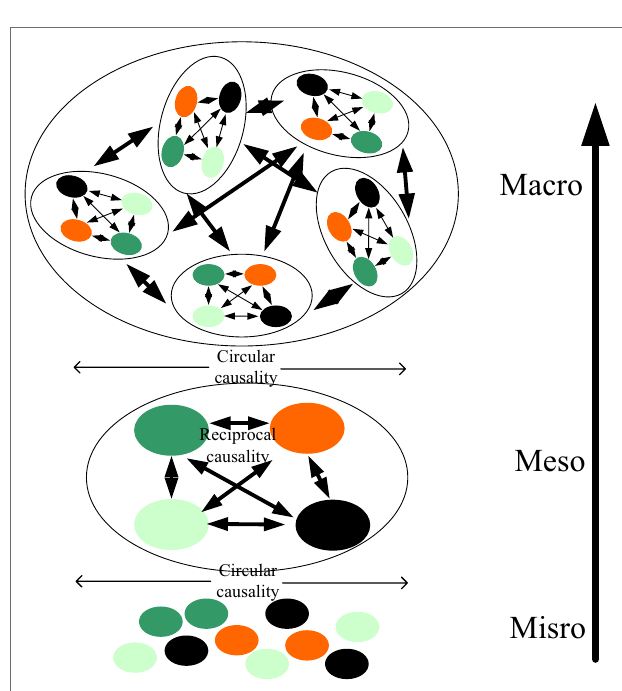
FIGURE 6 | System